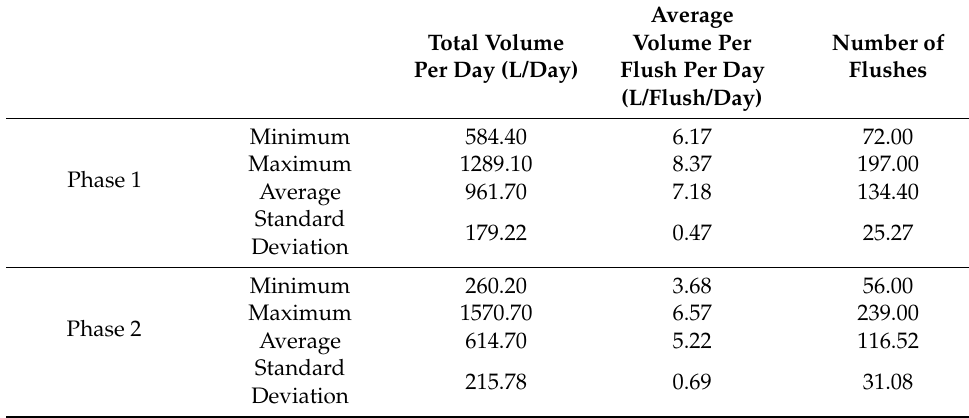
Table 2. Female Restrooms—Phases 1 and 2 summaries.